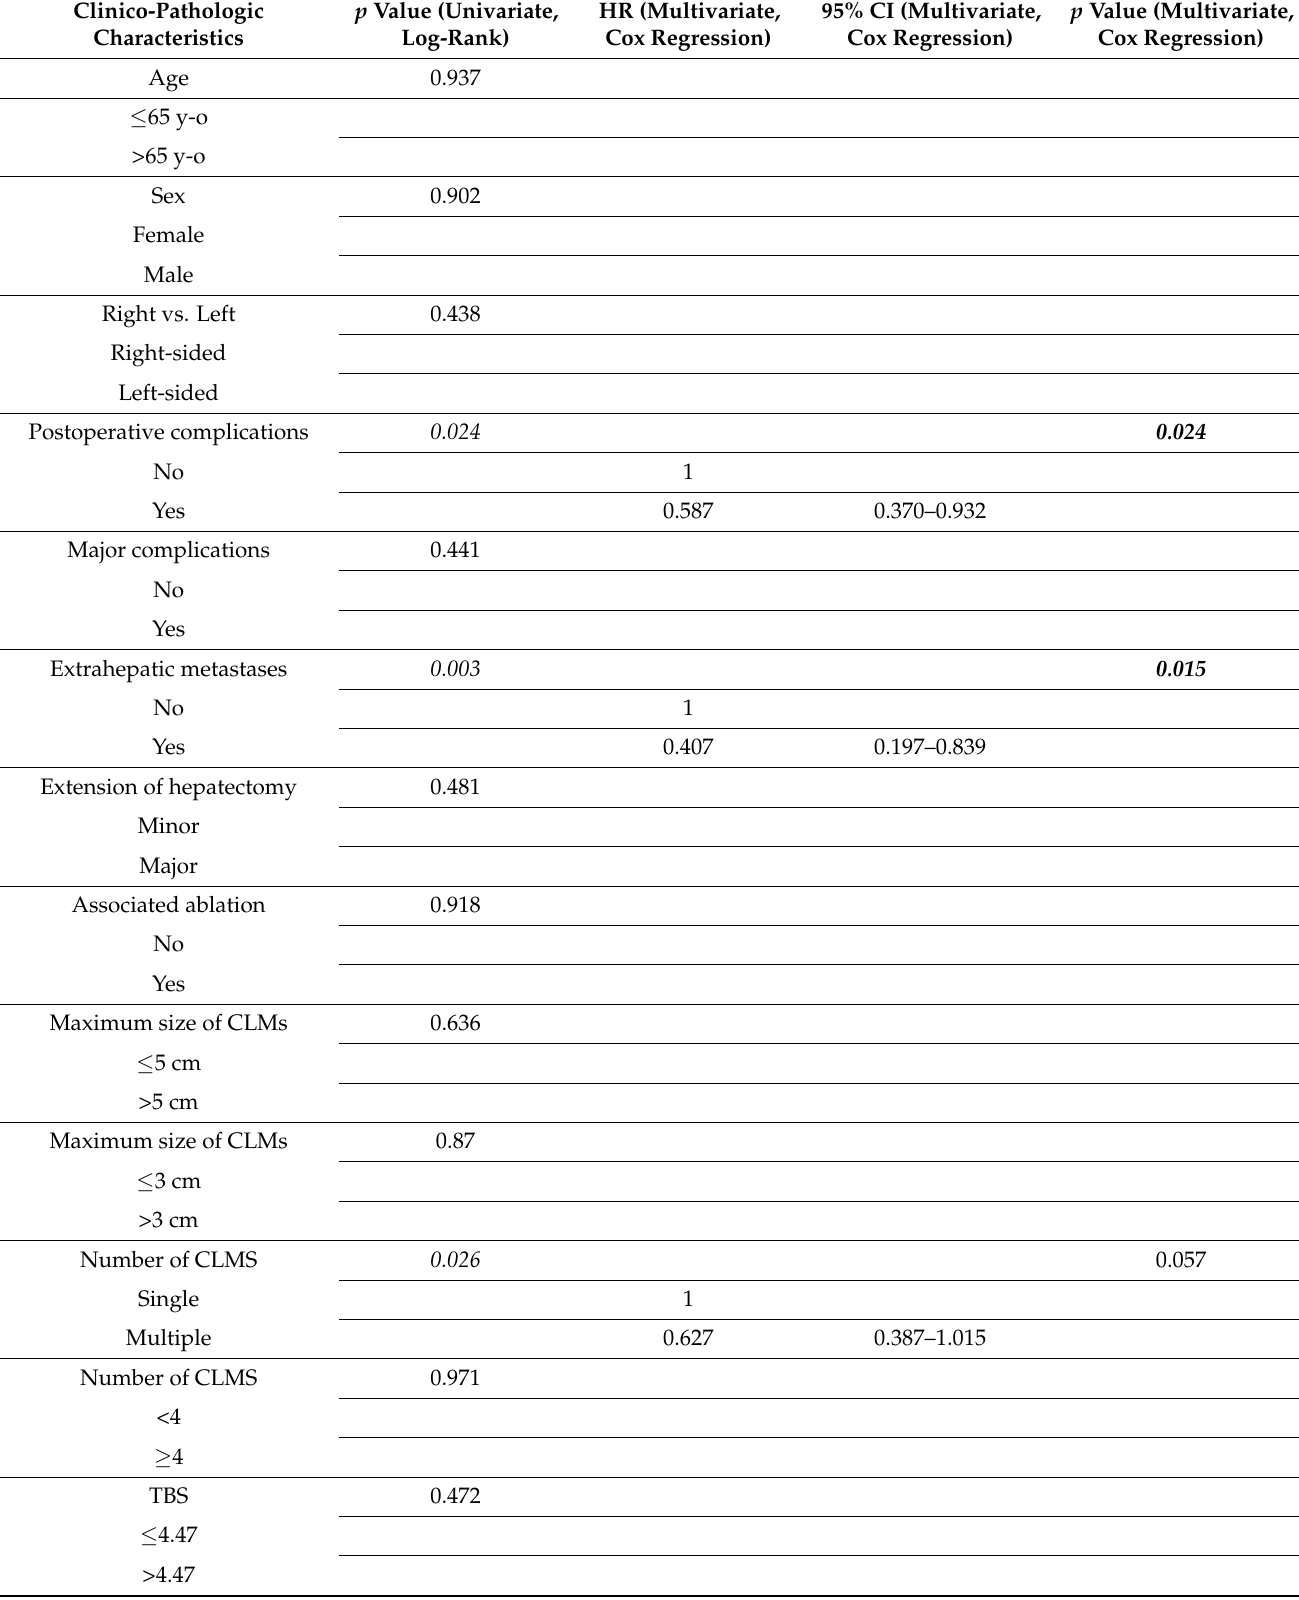
Table 3. Univariate and multivariate analysis for RFS in RAS-wt